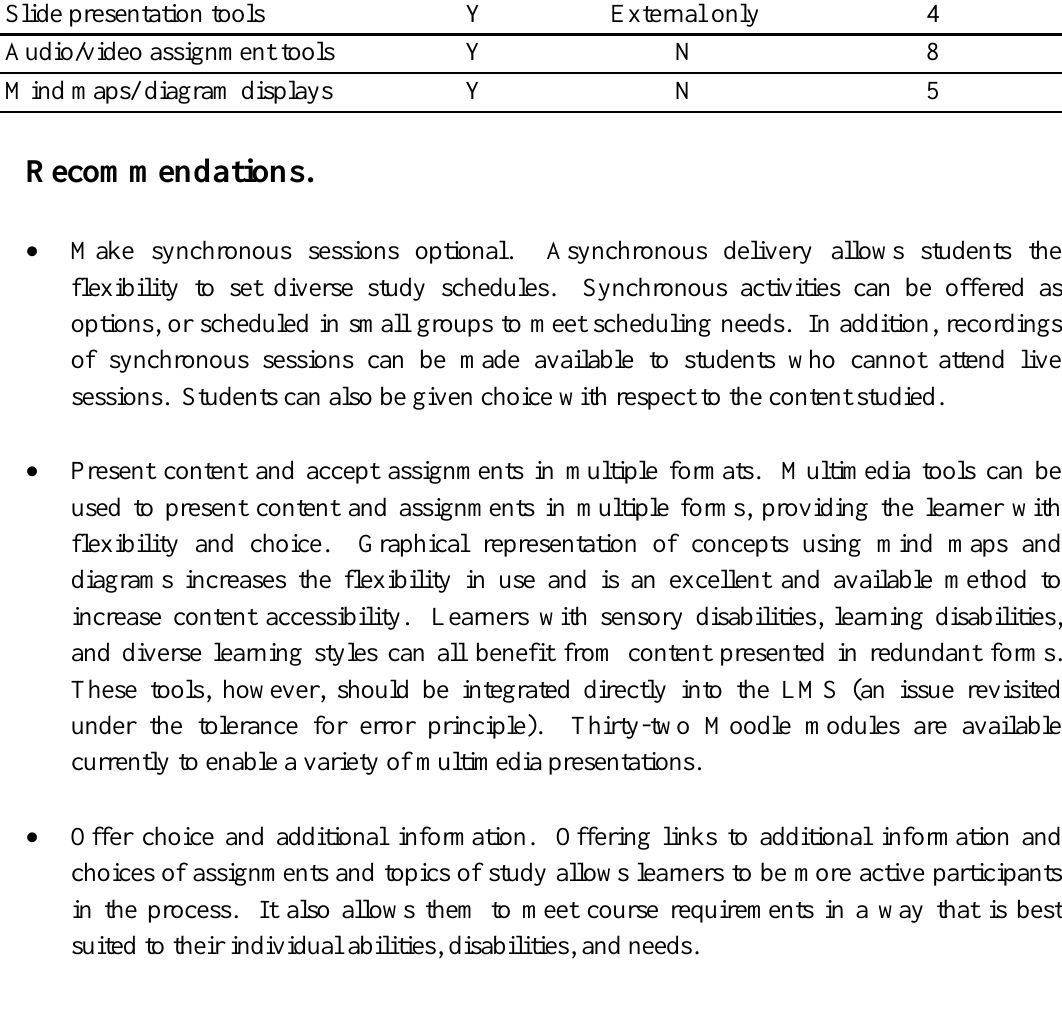
Availability of Moodle Modules Serving the Flexible Use Principle Flexible use Available in Used in sample Number of modules Moodle? course? Links to additional information Y Y Standard feature Choice of topics/ assignments Y Y Standard feature Conferencing tools Y Text only 22 Audio/video presentation tools Y External only Slide presentation tools Audio/video assignment